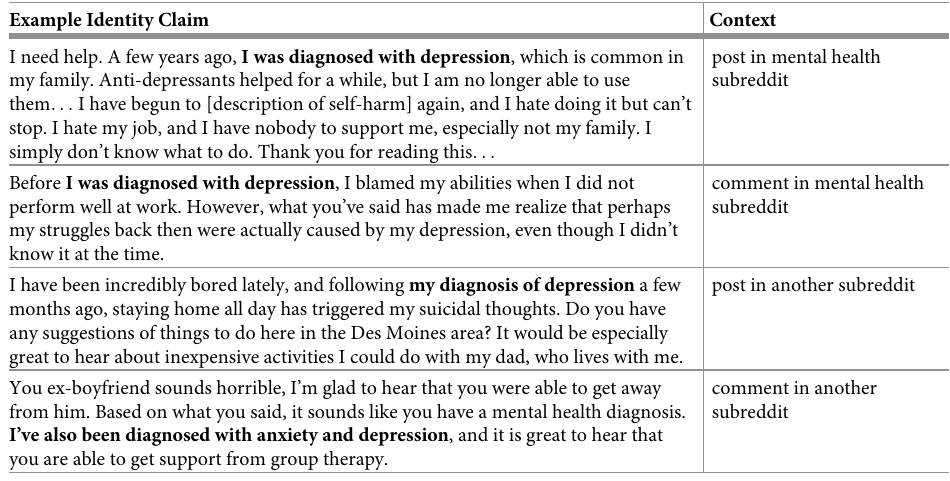
Table 1. Paraphrased examples of posts containing identity claims from our